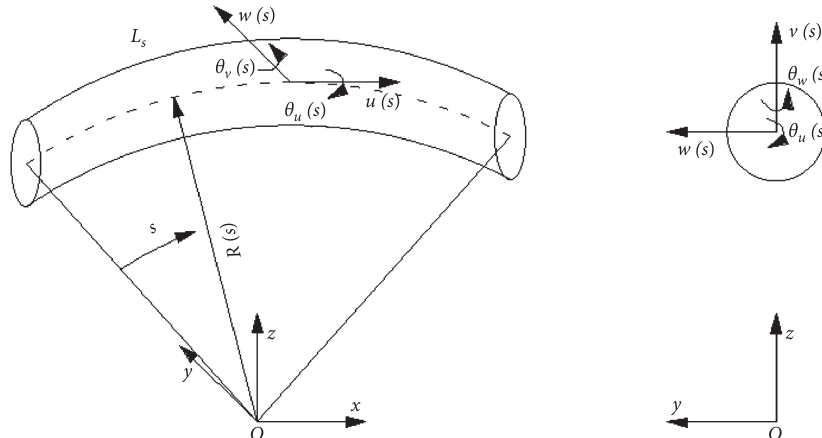
Figure 1: Schematic diagram of the curved beam model.